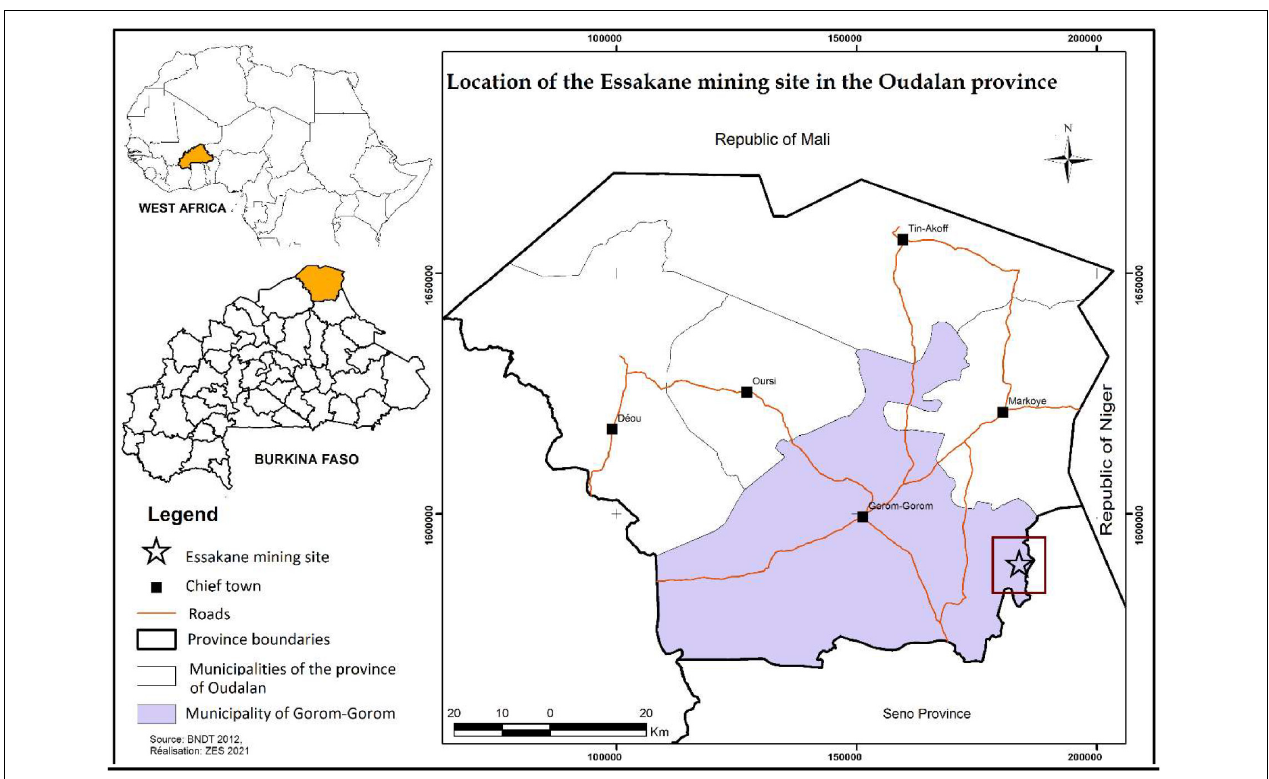
FIGURE 1 | Location of the Essakane mining site in the Province of Oudalan, north-eastern Burkina